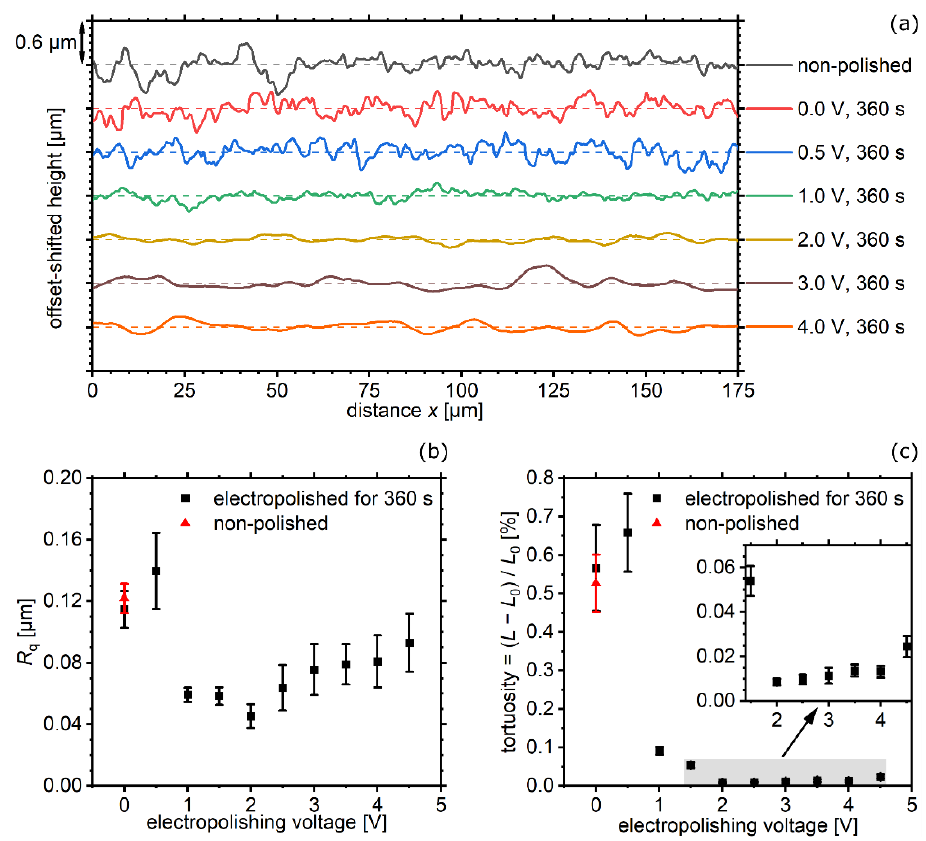
Figure 3. ( a ) Representative confocal laser scanning microscopy line profiles from samples electropolished at different voltages as well as the evaluations of ( b ) 𝑅 q and ( c ) tortuosity using the average of thirteen line profiles.